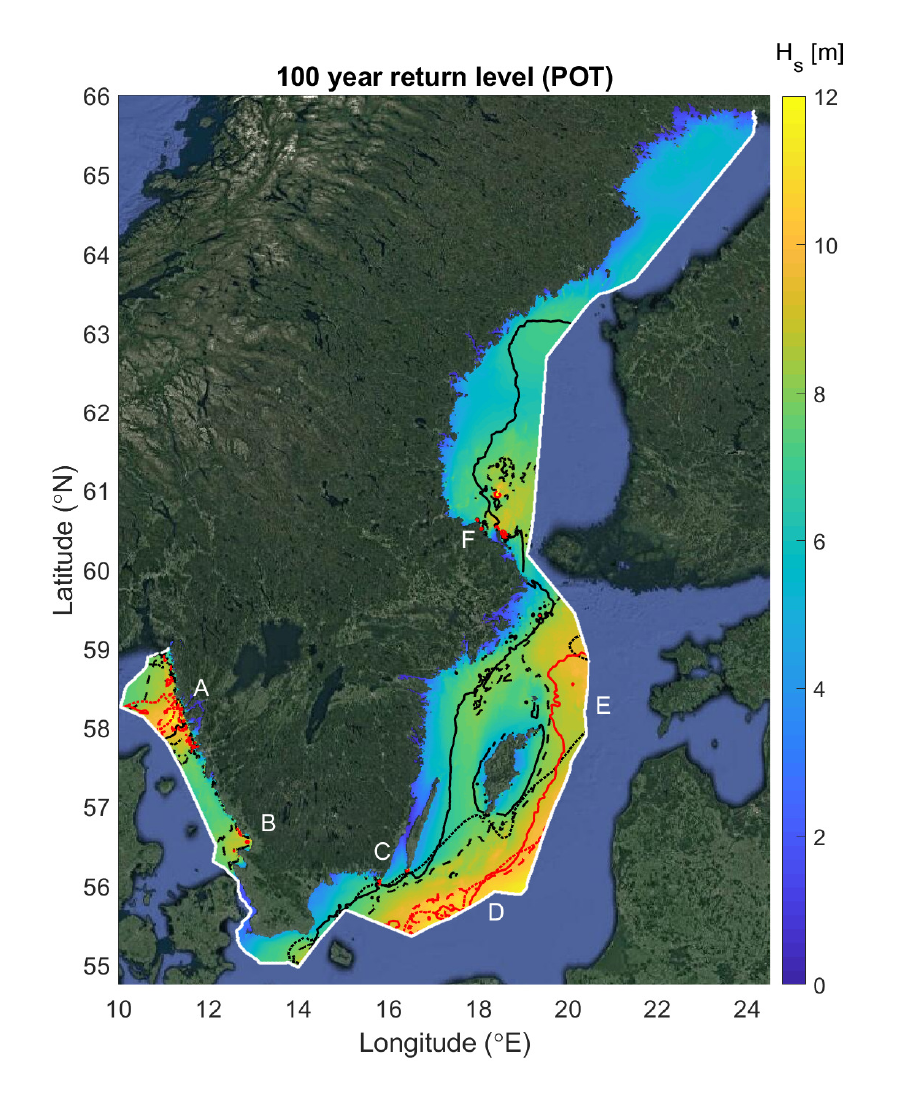
Figure 14. The 100 year return value for the significant wave height from a Peaks-Over-Threshold (POT) method is shown for the SEEZ region with red iso-lines marking values above 10 m and black above 8 m. The background colored field and dashed lines show the results from the high-resolution dataset from [6]. The red and black full lines show the results from a 45 year dataset from [52] and dotted lines from a 44 year dataset from [51]. Some places are marked with symbols A-F for further discussion in the main